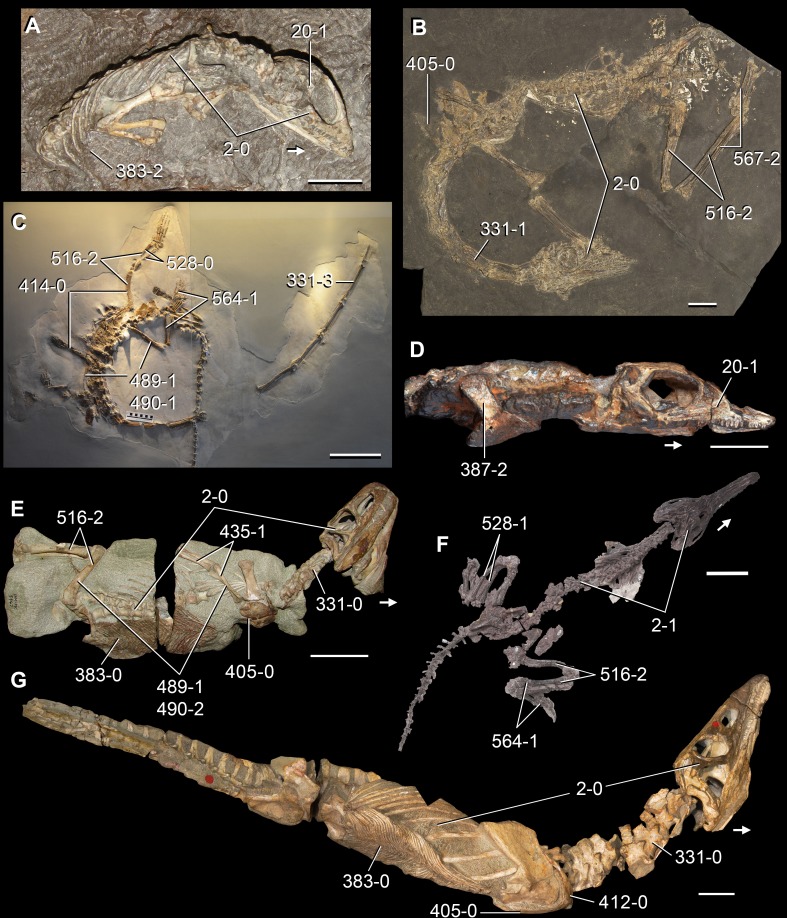
Partial skeletons of Permo-Triassic neodiapsids.(A) Youngina capensis in left lateral view (SAM-PK-K8565, mirrored), (B) Macrocnemus bassanii (PIMUZ T4355), (C) Tanystropheus longobardicus (PIMUZ T2817, mirrored), (D) Jesairosaurus lehmani in right lateral view (ZAR 06), (E) Euparkeria capensis (SAM-PK-5867), (F) Pseudochampsa ischigualastensis in dorsal view (PVSJ 567), and (G) Proterosuchus alexanderi in left lateral view (NMQR 1484, mirrored). Numbers indicate character-states scored in the data matrix and the arrows indicate anterior direction. Scale bars equal 1 cm in (A, D), 2 cm in (B), 20 cm in (C), and 5 cm in (E–G).